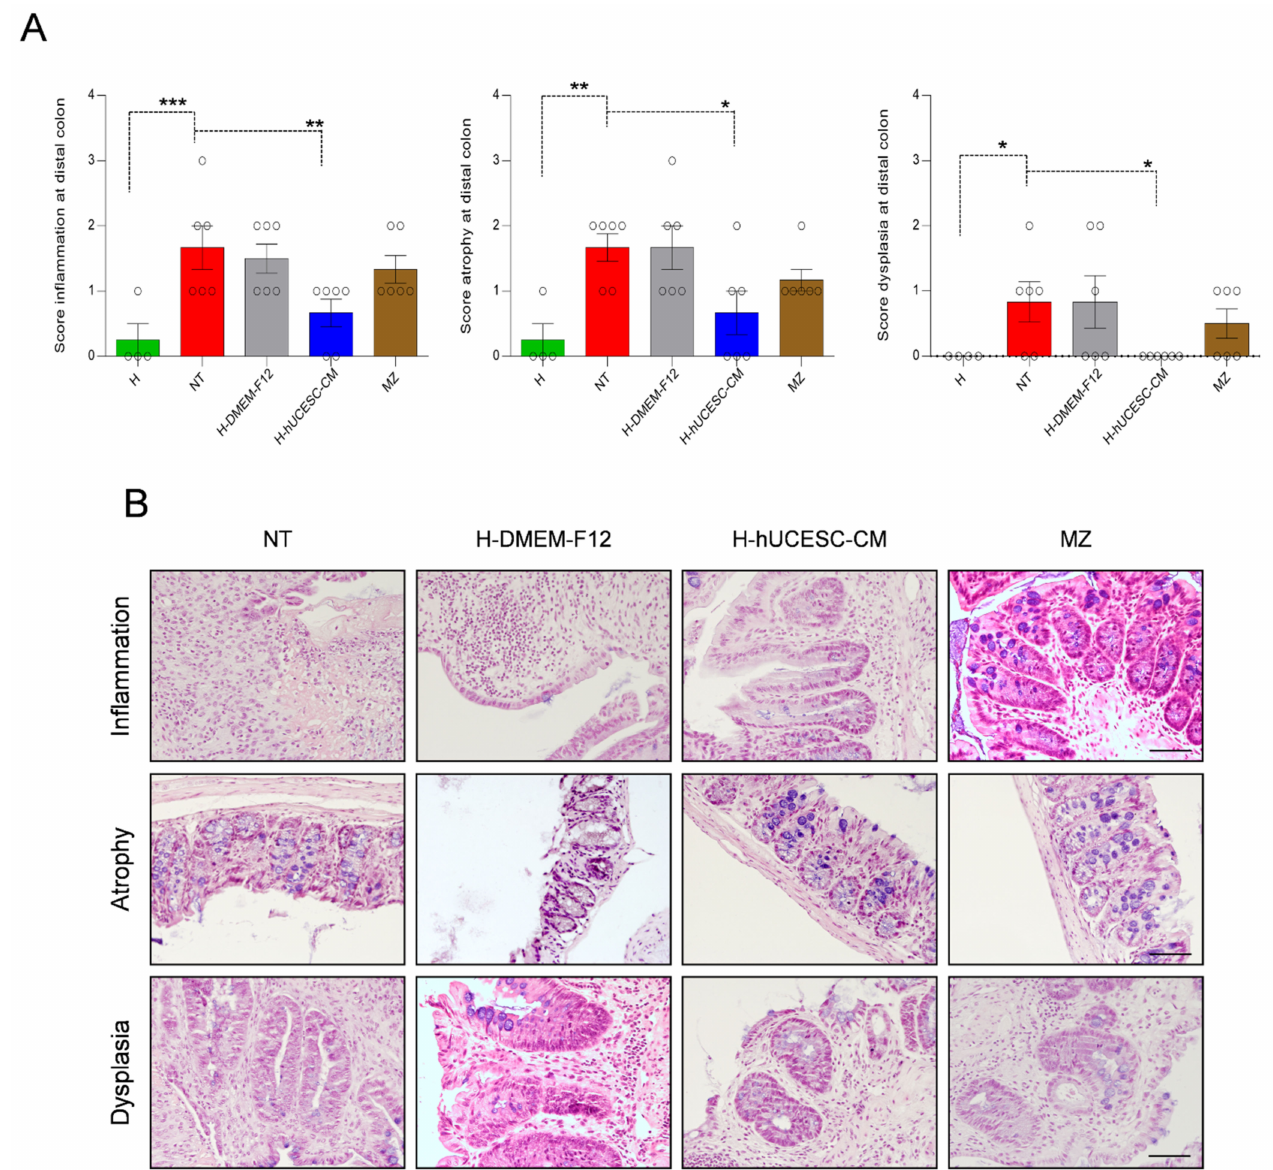
Figure 6. Representative histological score in the distal colon fragment. ( A ) Score values of inflammation, atrophy, and epithelial dysplasia in healthy (H), and treated and non-treated DSS-induced mice. ( B ) Microphotography of representative examples of inflammation, atrophy, and dysplasia in DSS-induced mice, non-treated (NT) and treated with H-DMEM-F12, H-hUCESC-CM, and mesalazine (MZ). * = p < 0.05; ** = p < 0.01; *** = p < 0.001. Scale bar: 100 µ